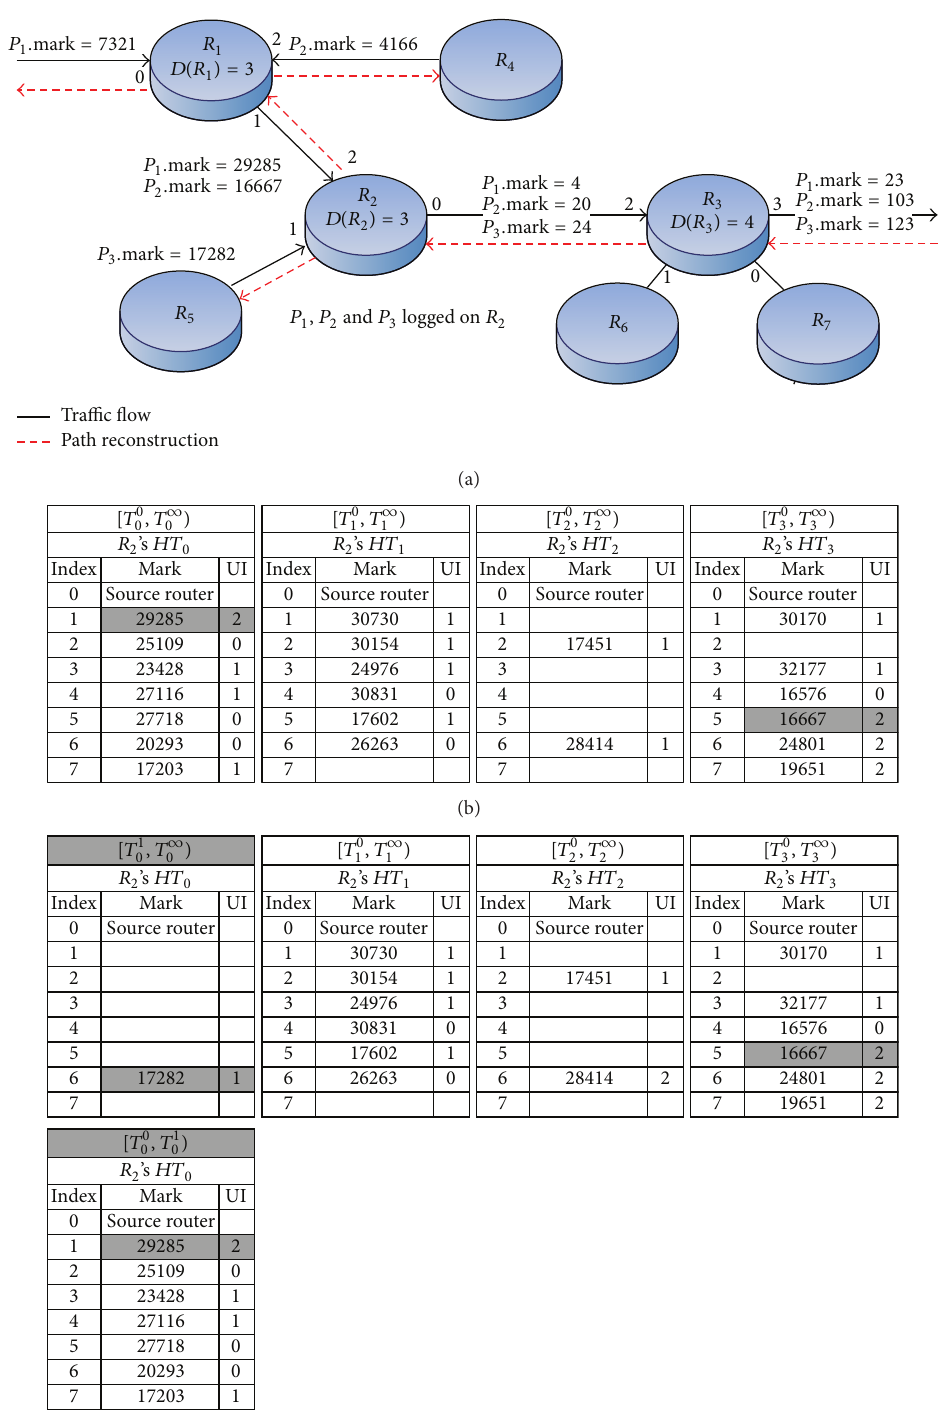
Figure 3: (a) Traffic flow of packets 𝑃 1 , 𝑃 2 , and 𝑃 3 . (b) Router 𝑅 2 ’s log tables. (c) Generating a new 𝐻𝑇 0 when 𝑅 2 ’s 𝐻𝑇 0 is full.